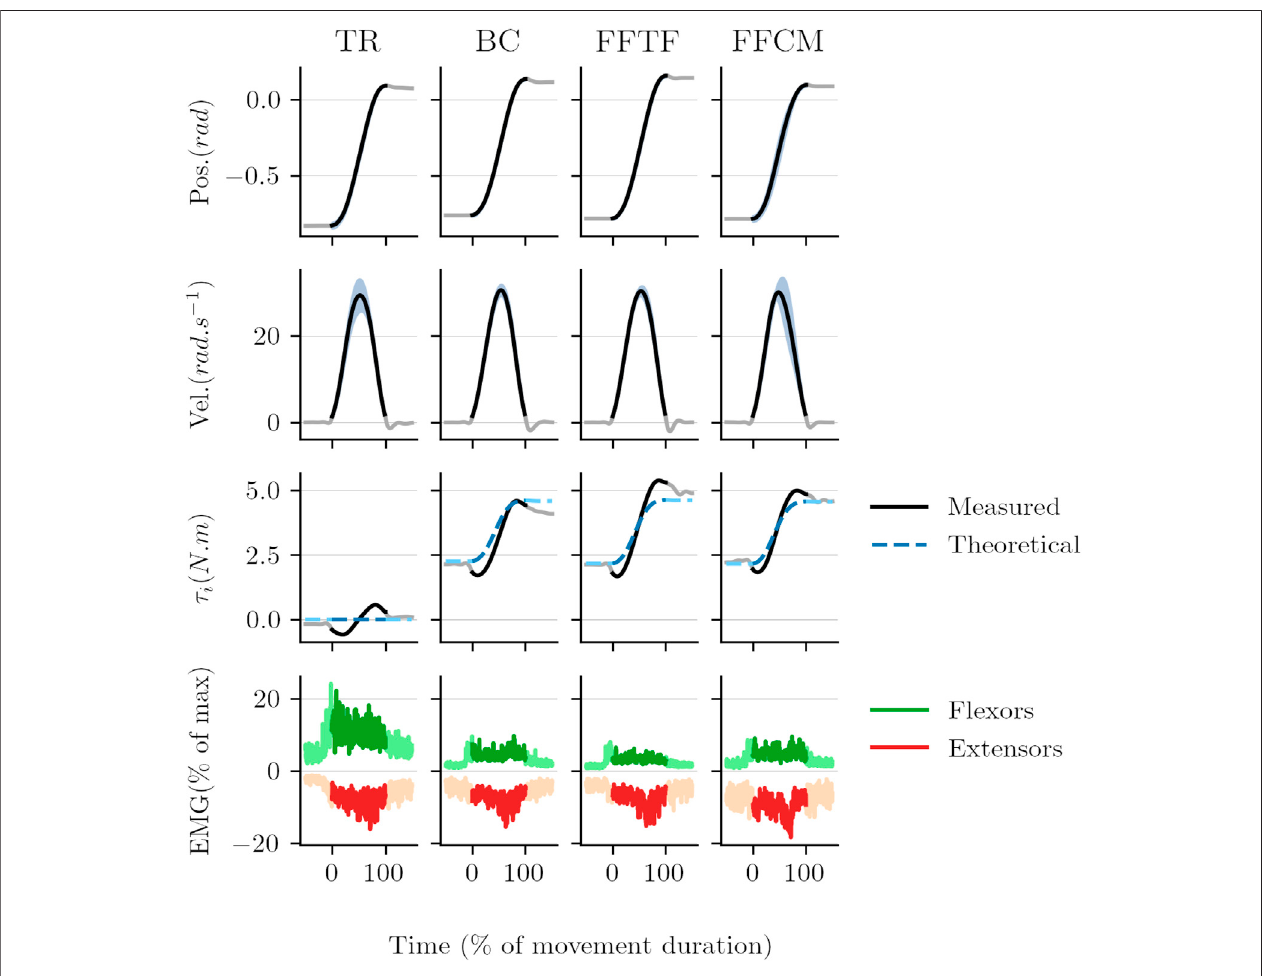
FIGURE 9 | Trajectories, torques, and muscular activation averaged for one participant for upward movements. EMG normalized peak activations are reduced when compared to Figure 11 because of the averaging on multiple movements.